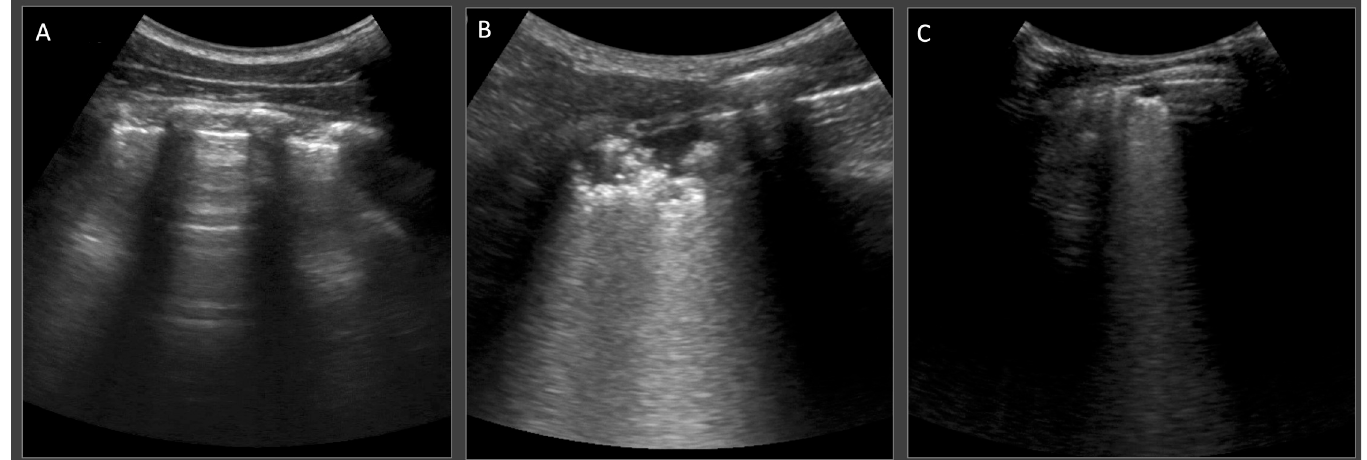
Fig 1. Typical thoracic ultrasound findings. Panel A demonstrates the appearance of normal air-filled lung, characterized by a bright white horizontal pleural line interrupted by rib shadows, and repeating horizontal reverberation artifacts known as A-lines. Panel B shows lung consolidation, characterized by subpleural echo-poor region greater than 10 mm in depth or length. Panel C demonstrates a small subpleural consolidation (SPC), characterized by a hypoechoic subpleural region less than 10 mm in depth and length, with distinct borders and a trailing comet-tail